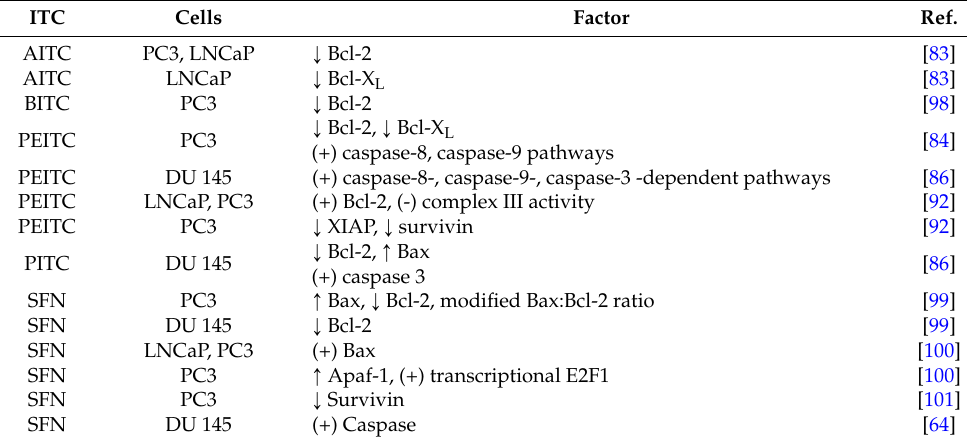
Table 3. Effects of ITCs on apoptosis in vitro